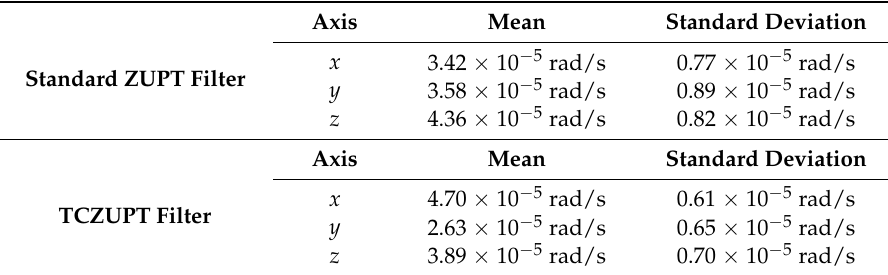
Table 9. Mean and Standard Deviation (nominal conditions, 5 data sets).